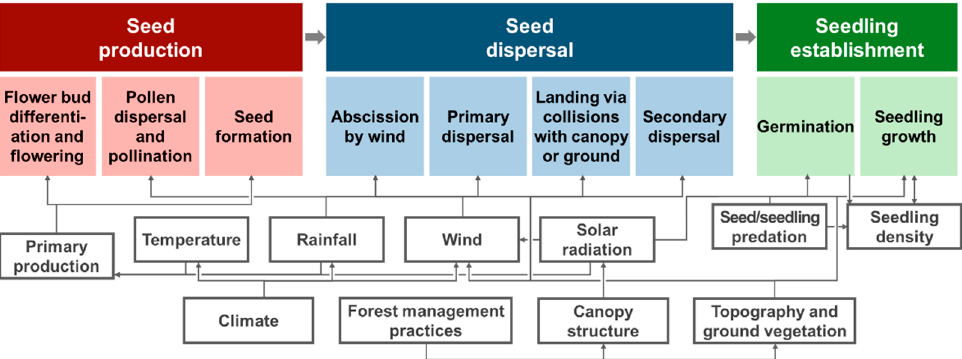
Figure 1. Natural regeneration processes from seed production to seedling establishment of tall forest trees depend on wind-dispersal of seeds. Microclimate (e.g., temperature, rainfall, wind, and solar radiation) and stand structure (e.g., canopy, topography, and ground vegetation) interactively regulate the regeneration processes. Human-induced transformations due to climate change and forest management practices could alter microclimate and stand structure, respectively.